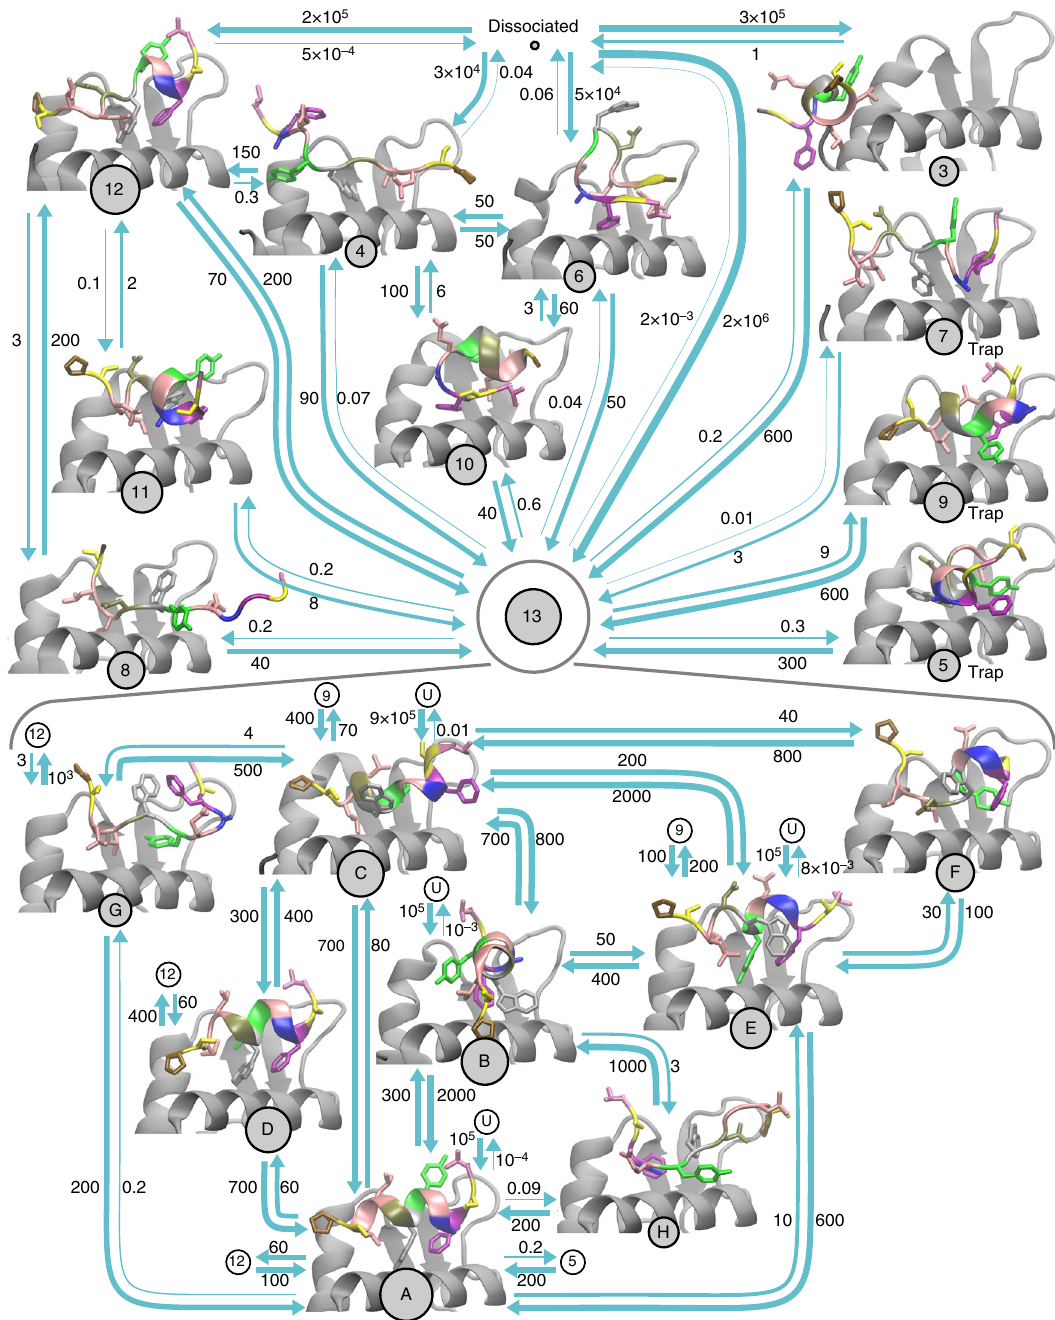
Fig. 1 Metastable states and transition rates for the binding of PMI to Mdm2. The PMI peptide is colored according to ( ). States are represented by discs with areas proportional to the natural logarithm of the equilibrium probability. Arrows indicate transitions with rate constants of at least 1 ms − 1 in either direction. Numbers quantify transition rate constants in ms − 1 M − 1 for association events and in ms − 1 for all other transitions. The de fi nition of the states is hierarchical: between top-level states 0 and 13, transitions happen on timescales of 10 µ s or slower. States in the lower part of the fi gure are sub-states of top-level state 13. There, PMI transitions between different states in the main binding pocket of Mdm2 on timescales of microseconds or slower (only states with large probabilities are